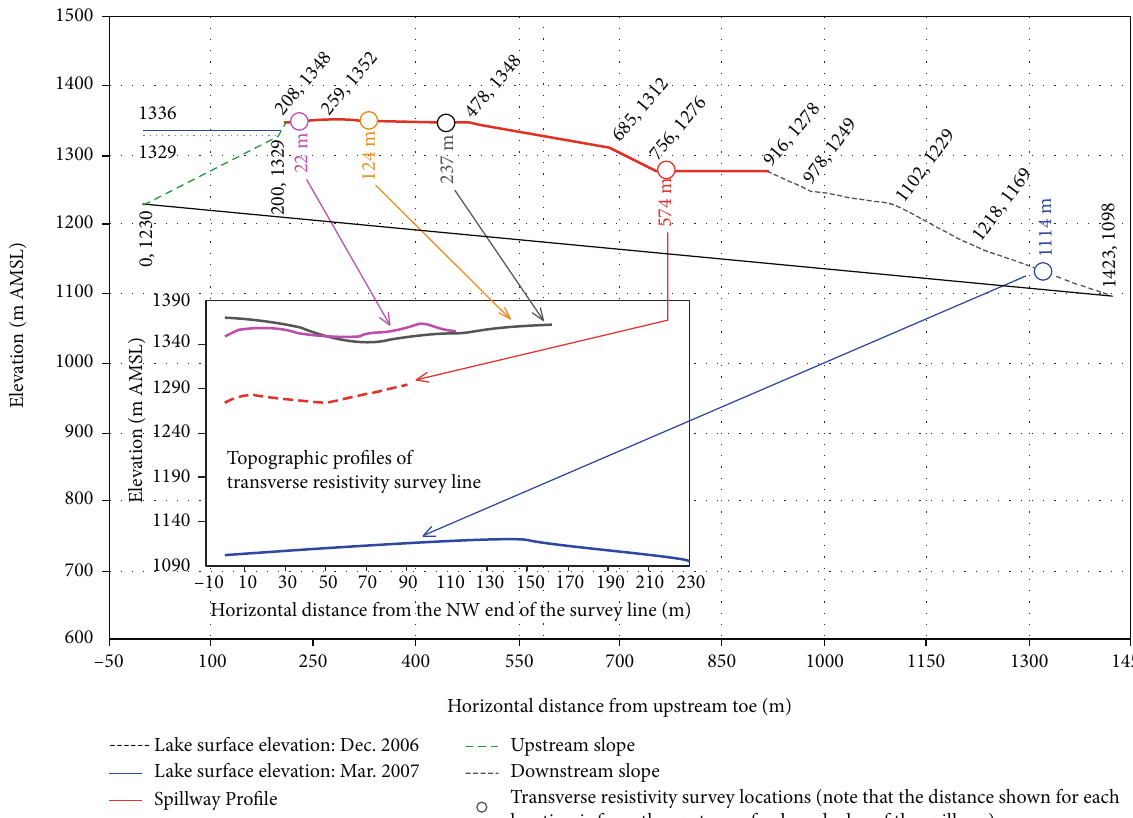
Figure 12: Surface topographic pro fi les of the lines for electrical resistivity surveys; the longitudinal survey line along the Karli spillway and the transverse resistivity locations are shown in the main graph, while the transverse survey lines at 22m, 124m, 237m, 574 m, and 1114 m from the start point of the spillway are shown in the inserted